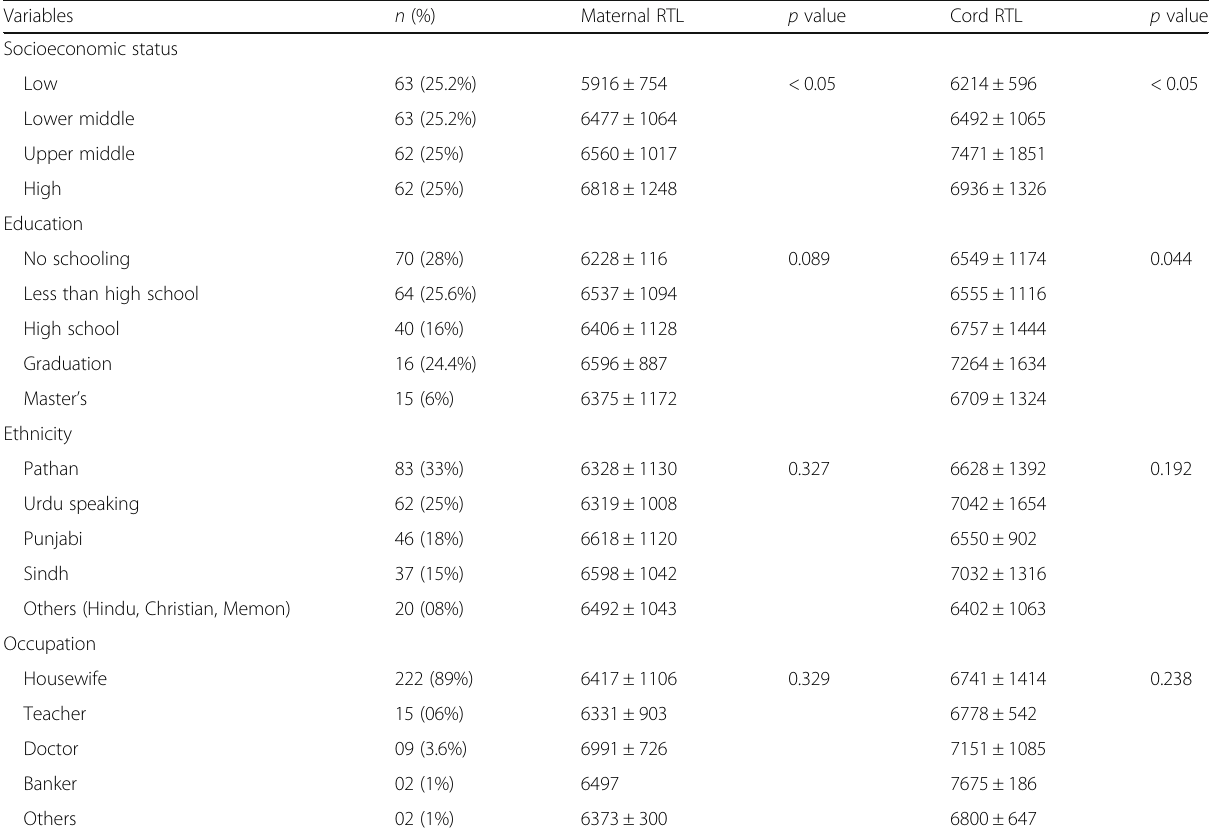
percentages. Spearman ’ s correlation was used to check the correlation of maternal and cord blood RTL at 95% confidence level and p = < 0.05 significant. The Kruskal- Table 1 Demographic variables of mother and its association with RTL of mother and cord